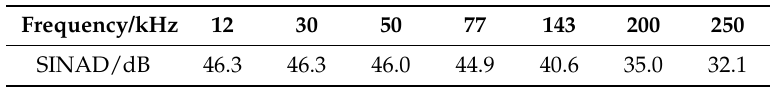
Table 2. Signal-to-noise and distortion (SINAD) ratio of the generated 1.5 mA current signal over frequency, measured over a 1 k Ω resistor.